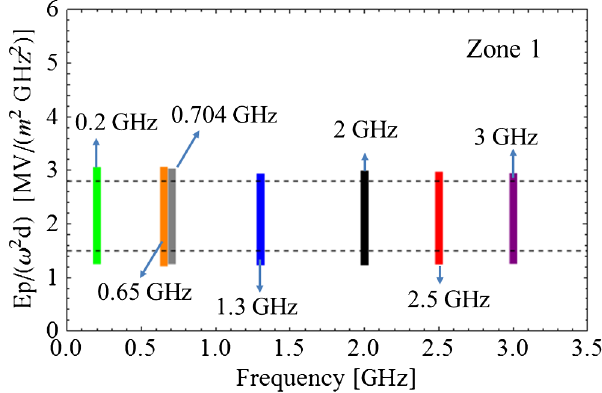
FIG. 11. Frequency scaling of zone 1 MP in HOM couplers of scaled TESLA-type cavities. The dashed lines are the lower and upper bound from the analytical prediction based on the parallel- plate model.